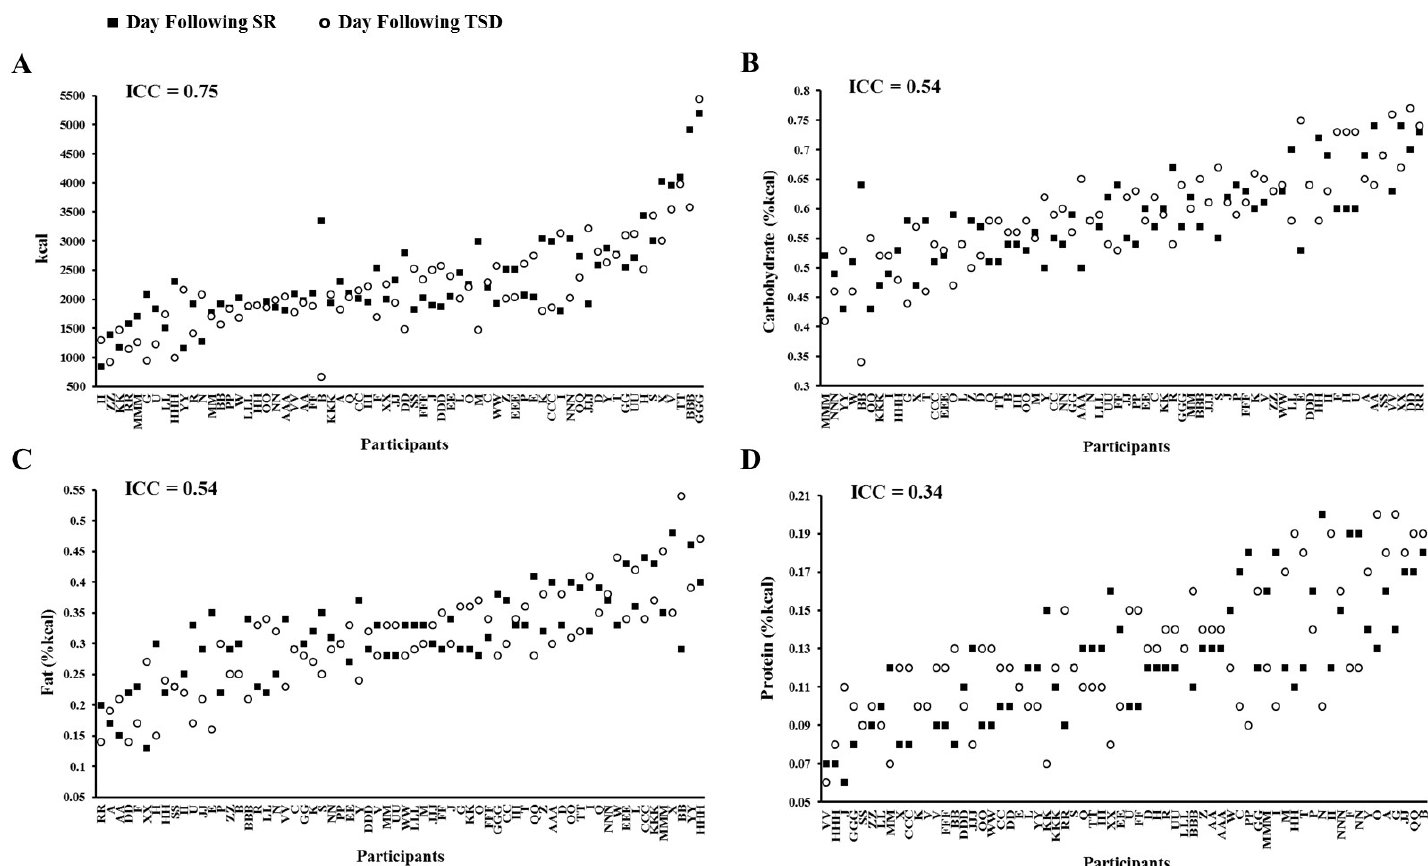
Figure 4. Individual differences and substantial phenotypic stability of caloric and macronutrient intake measures to sleep restriction (SR) and total sleep deprivation (TSD). Stability of caloric and macronutrient intake during the day following SR (08:00–22:00) and TSD (06:00–22:00) for ( A ) total caloric intake; ( B ) percentage of caloric intake from carbohydrates; ( C ) percentage of caloric intake from fat; and ( D ) percentage of caloric intake from protein. Participants (denoted individually with letters) are plotted in ascending order based on the mean intake of both sleep loss exposures (SR and TSD). See text for ICC ranges.